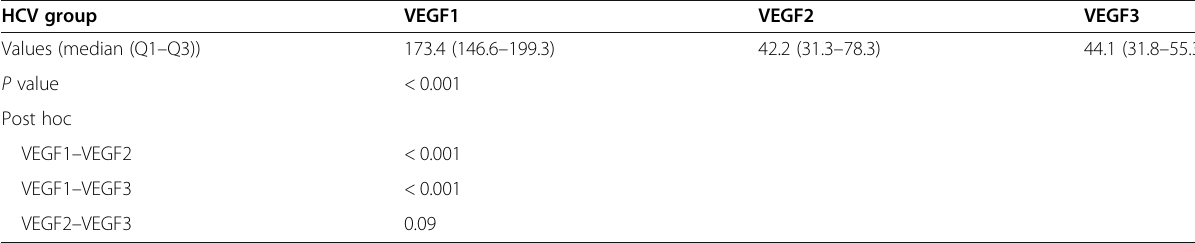
Table 3 VEGF through the study period